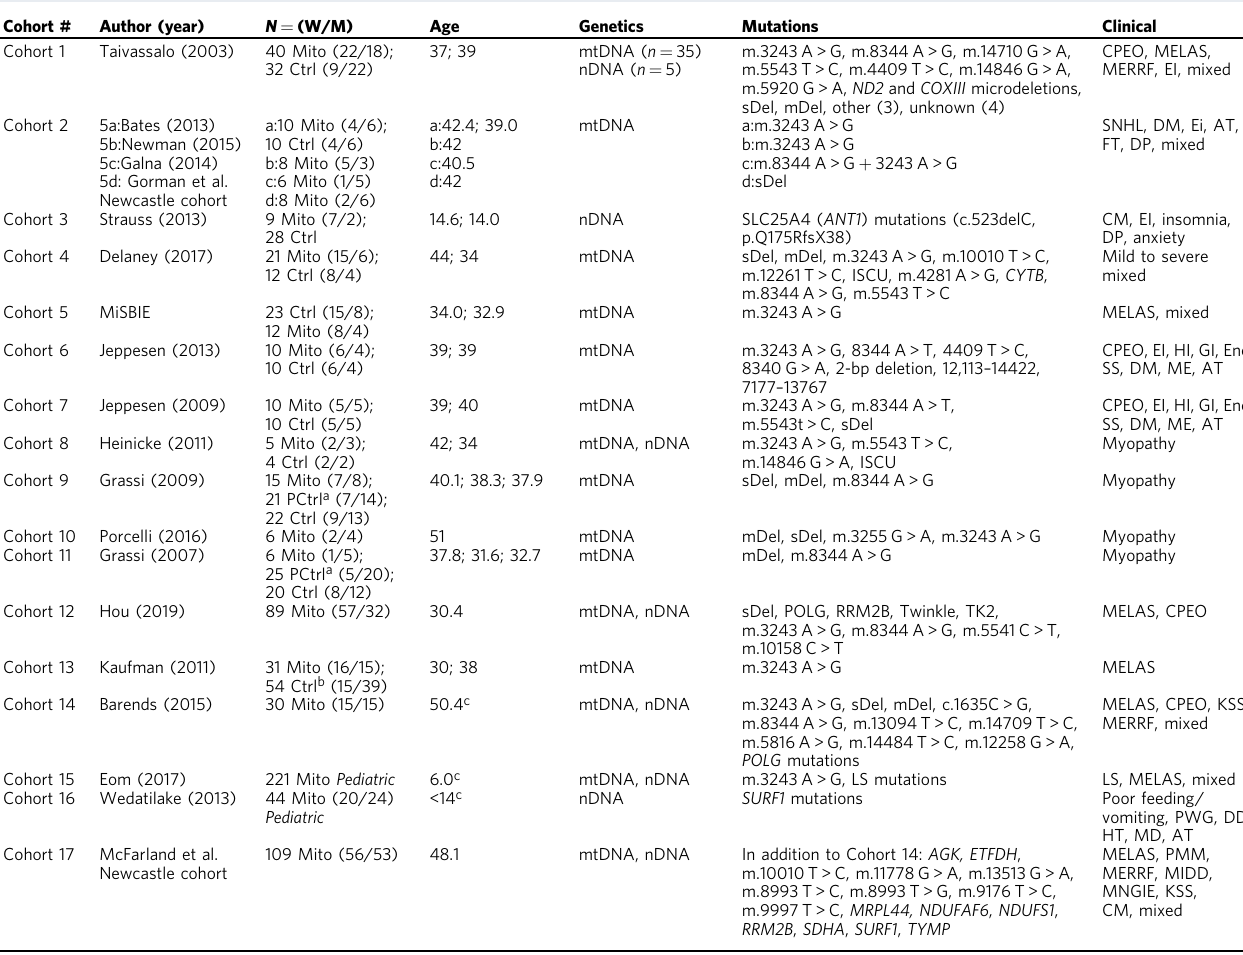
Table 1 Human cohorts included in the quantitative meta-analysis of energy expenditure and related clinical phenotypes in patients with mitochondrial diseases (see Fig.